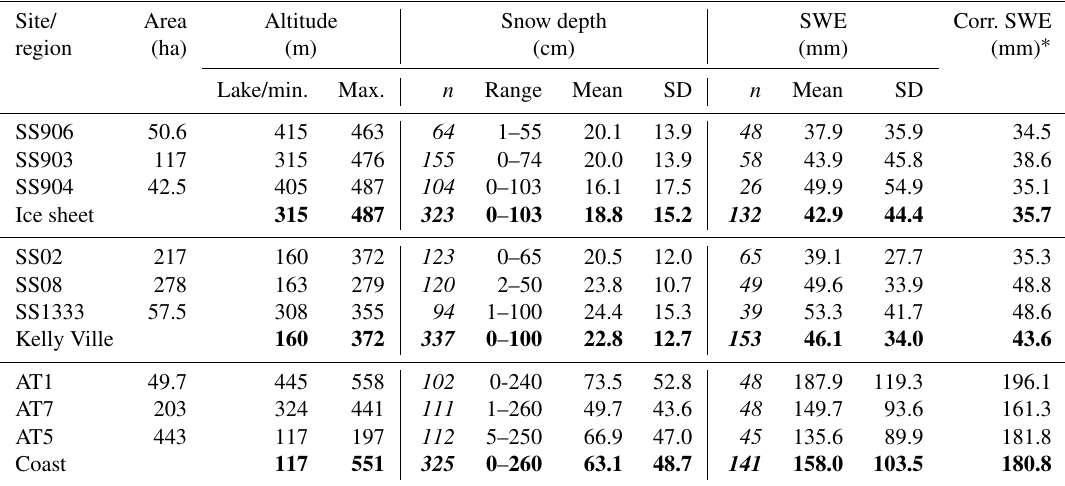
Table 2. Snow depth measurements and snow water equivalents (SWE) by catchment and region. Sample number ( n ) in italics; regionally aggregated data in bold. Site/ Area Altitude Snow depth SWE Corr. SWE region (ha) (m) (cm) (mm) (mm) ∗ Lake/min. Max. n Range Mean SD n